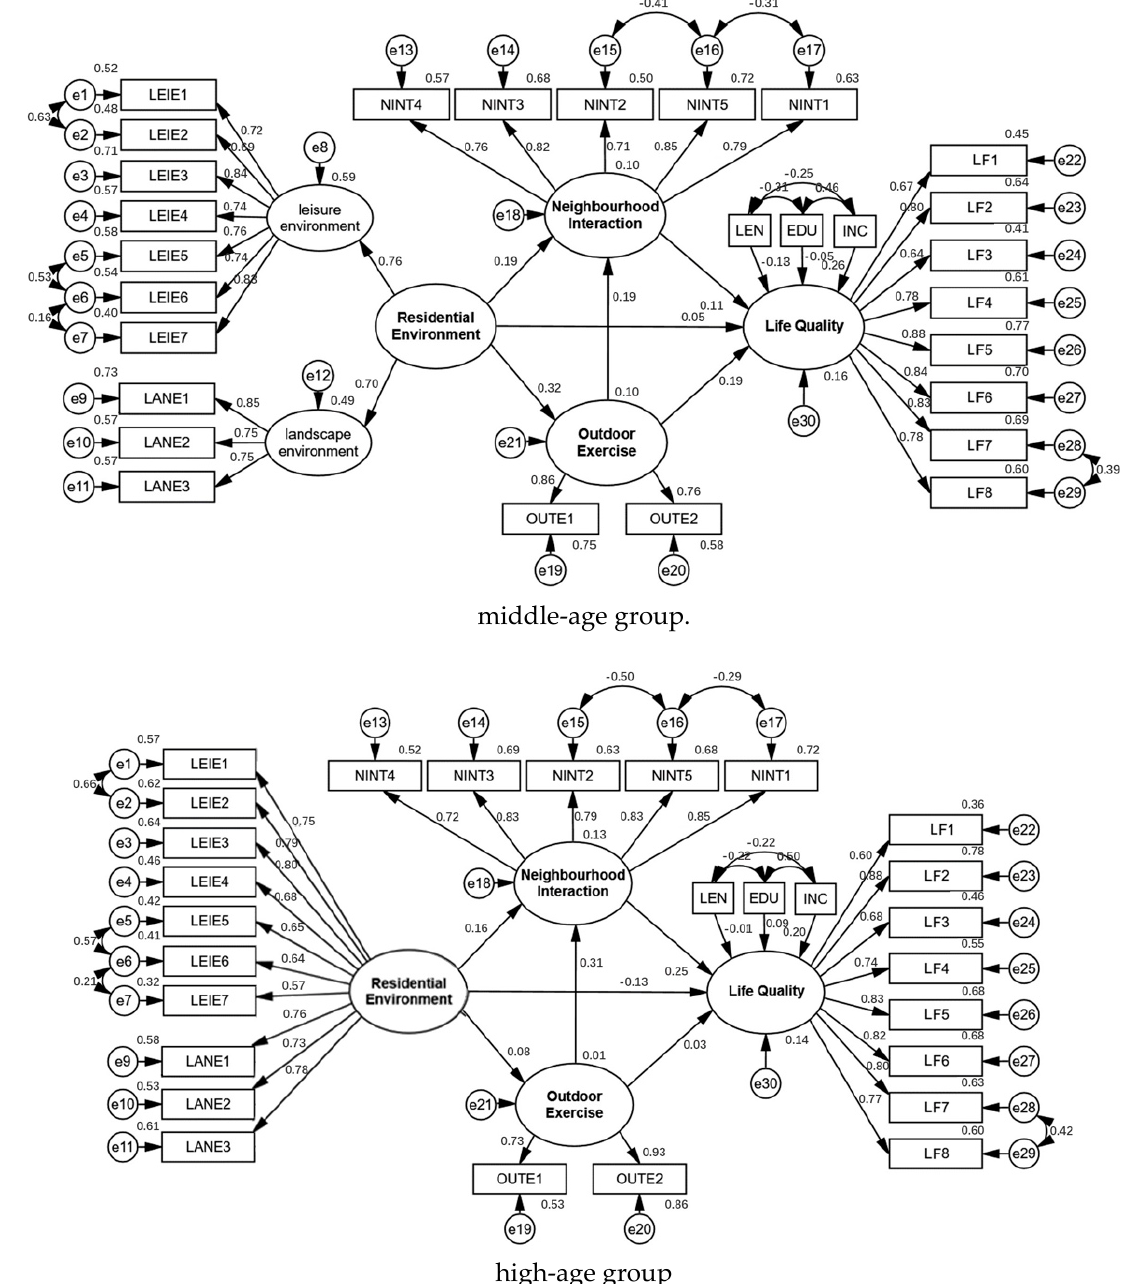
Figure 5. Comparison of models for different age groups.